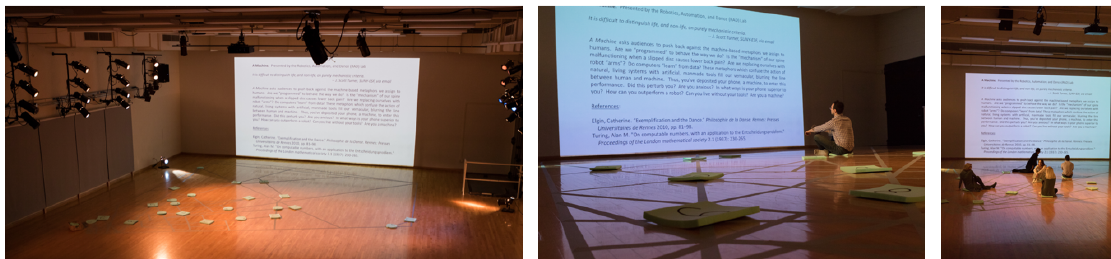
Figure 1. Seating audience members before the show. Low lighting and a sparse “environment” for participating audience members to sit in creates a stage that is a studio-like setting that feels lifted from the pages of a geometry textbook: natural wood grain contrasts thick industrial grey tape laid in a linear mesh; warm theatrical lights contrast cool white from a projector; and the voices of arriving audience members contrast electronic ambient noises. Photos by Natalie